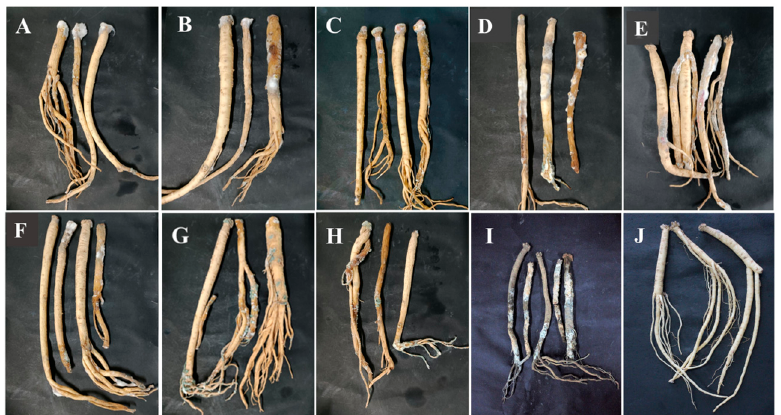
Figure 7. Pathogenicity testing of isolates from fresh C. pilosula with postharvest disease during different storage stages. ( A ) Actinomucor elegans ; ( B ) Mucor hiemalis ; ( C ) Fusarium acuminatum ; ( D ) Fusarium equiseti ; ( E ) Fusarium oxysporum ; ( F ) Clonostachys rosea ; ( G ) Penicillium expansum ; ( H ) Penicillium aurantiogriseum ; ( I ) Trichothecium roseum . ( J ) Control (no inoculation). 3.6. Ozone Fumigation Inhibited the Development of C. pilosula Postharvest Disease